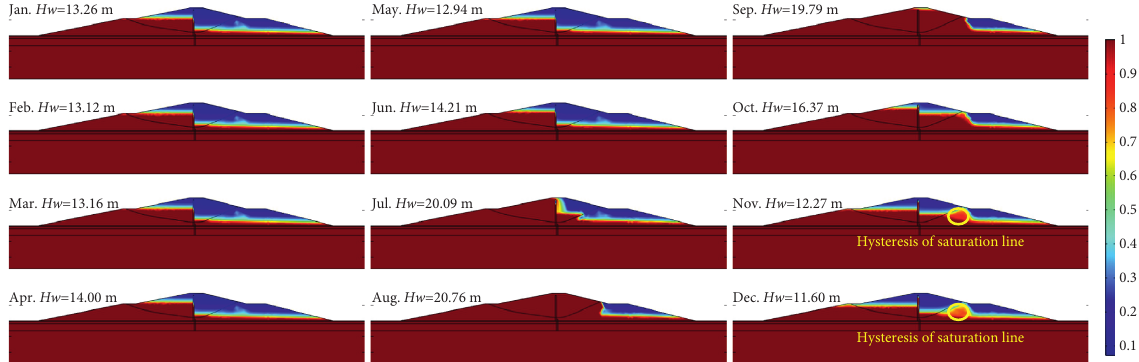
Figure 7: Change of the seepage line in the cofferdam under water-level